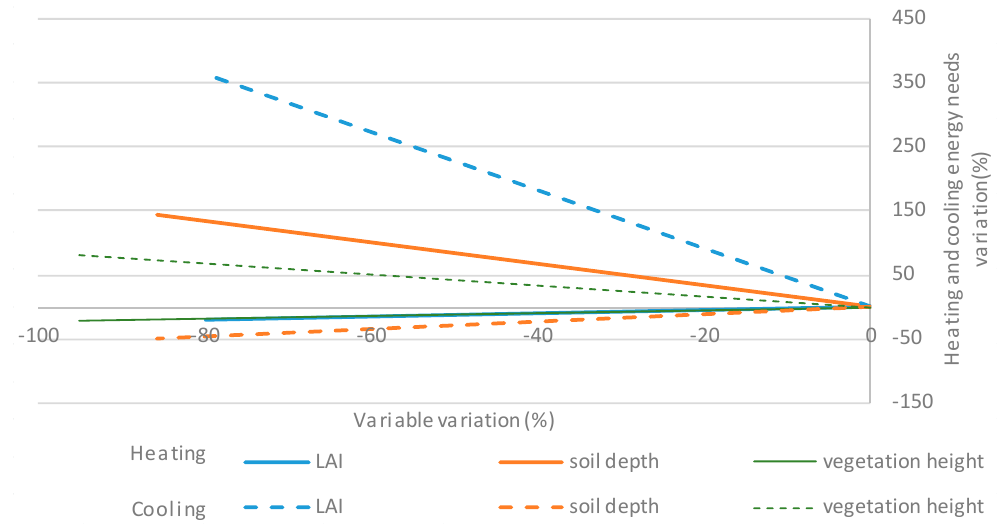
Figure 7. Impact of vegetation and substrate variation on heating and cooling energy needs.